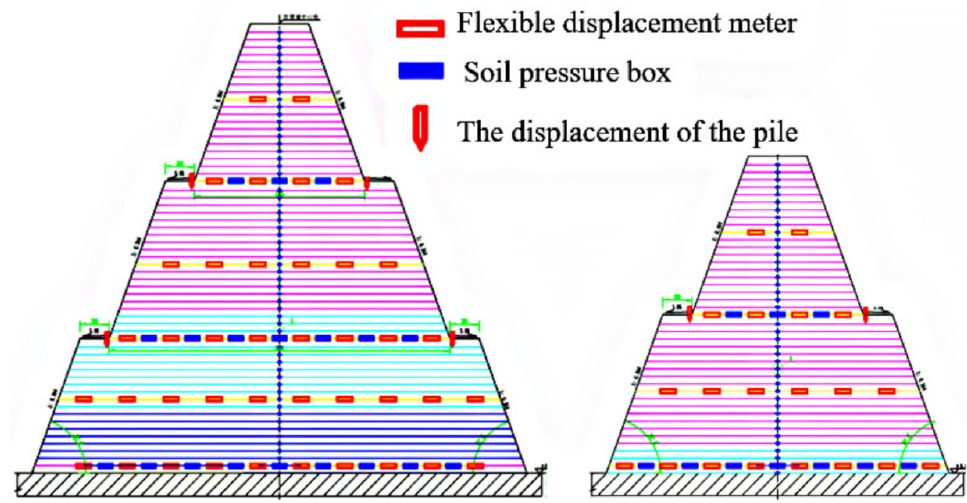
Figure 4. Cross-section layout of monitoring elements for high soil